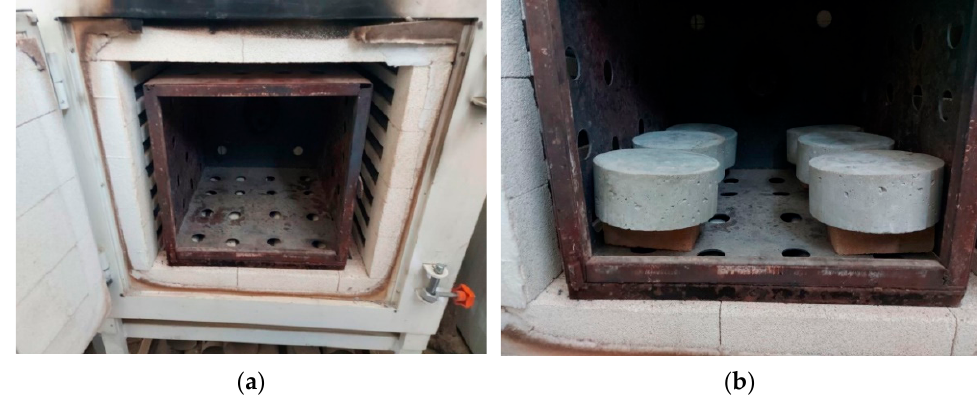
Figure 2. Heating of test specimens: ( a ) the used electrical furnace; ( b ) specimen heating.